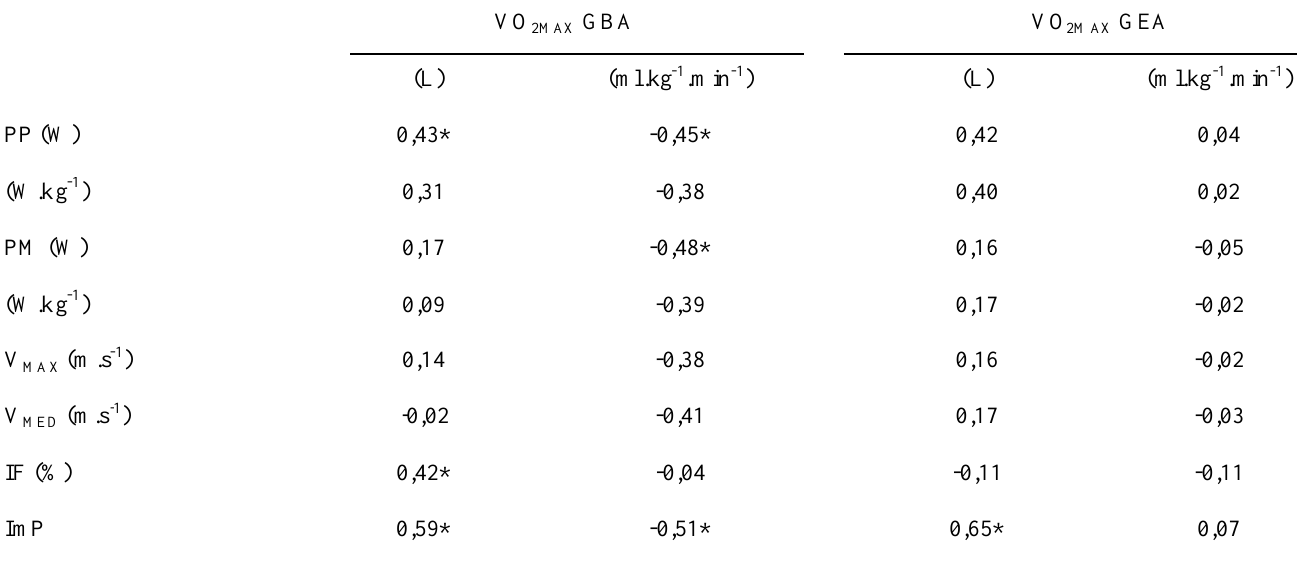
e as variáveis provenientes do 2MAX